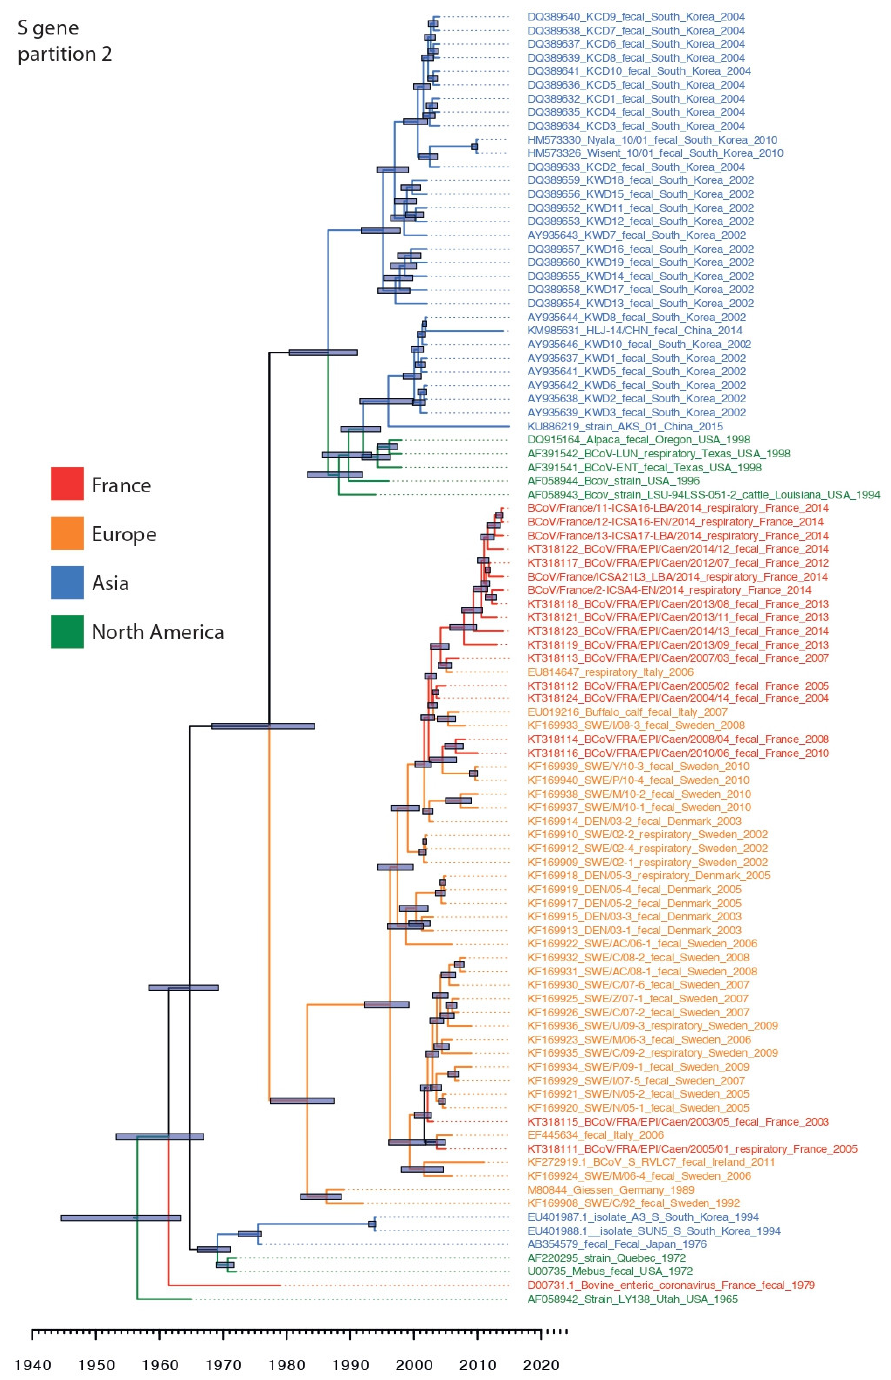
Figure 2. Dated phylogeny of BCoV S gene partition-2 (nt 1101–4089). Tree generated using the relaxed clock model and a constant coalescent tree prior. Nodes correspond to mean tMRCAs. 95% HPD are indicated on nodes with grey boxes. French sequences (including those generated in the present study), European, Asian, and North American sequences are in red, orange, blue, and green fonts, respectively.